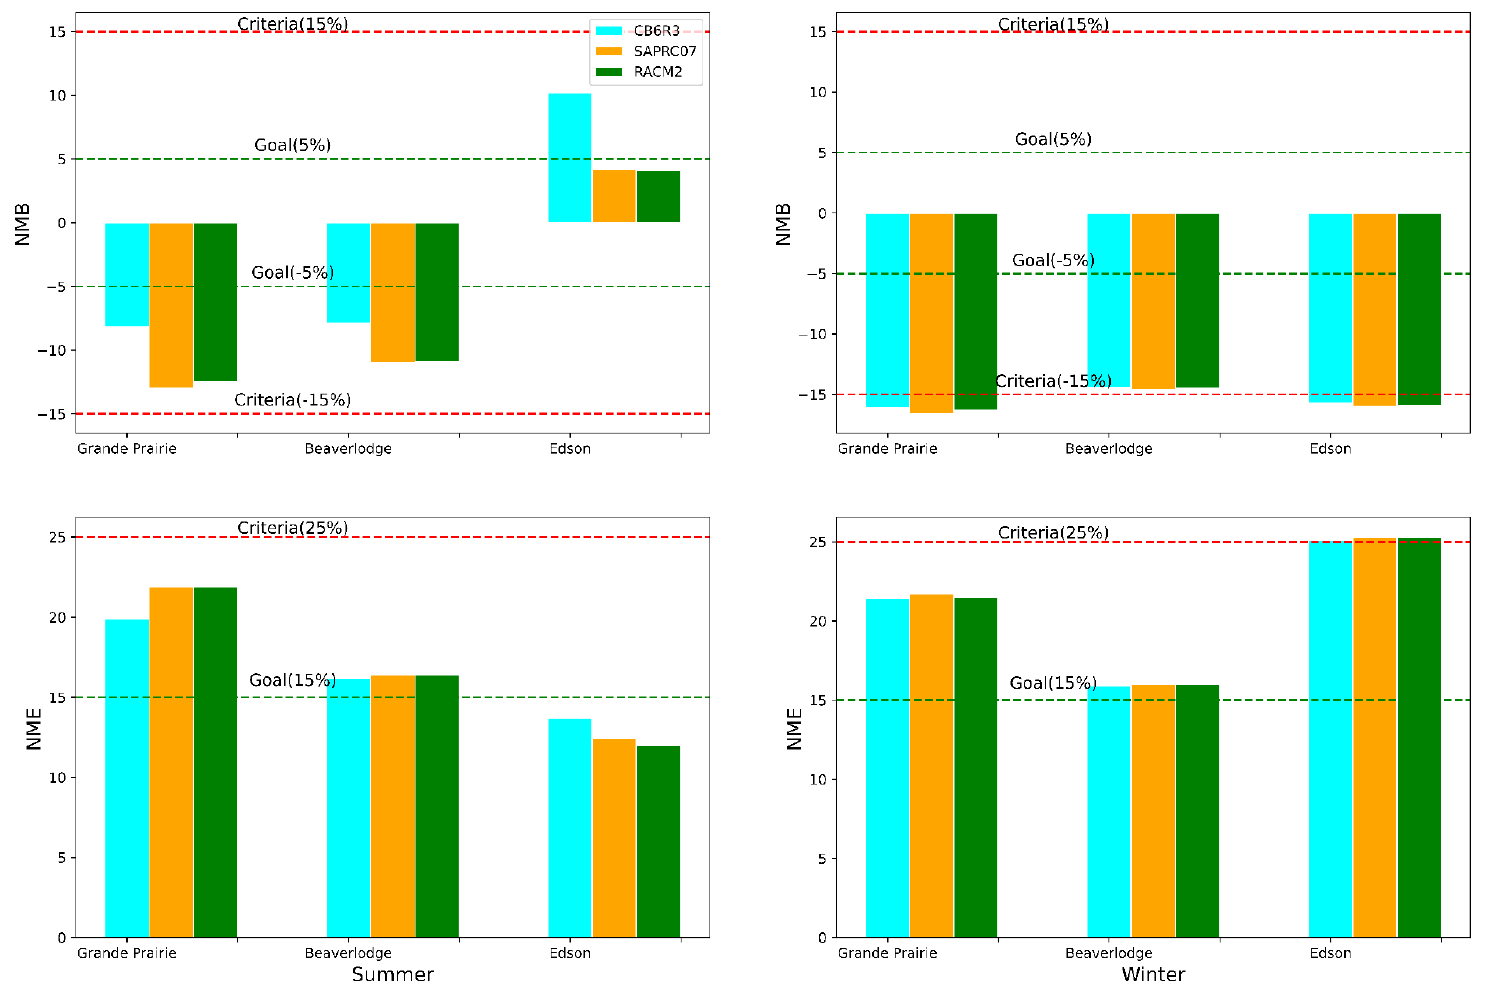
Figure 6. O 3 model performance, as measured by NMB and NME, at three ambient monitoring stations in summer ( left ) and winter ( right ).